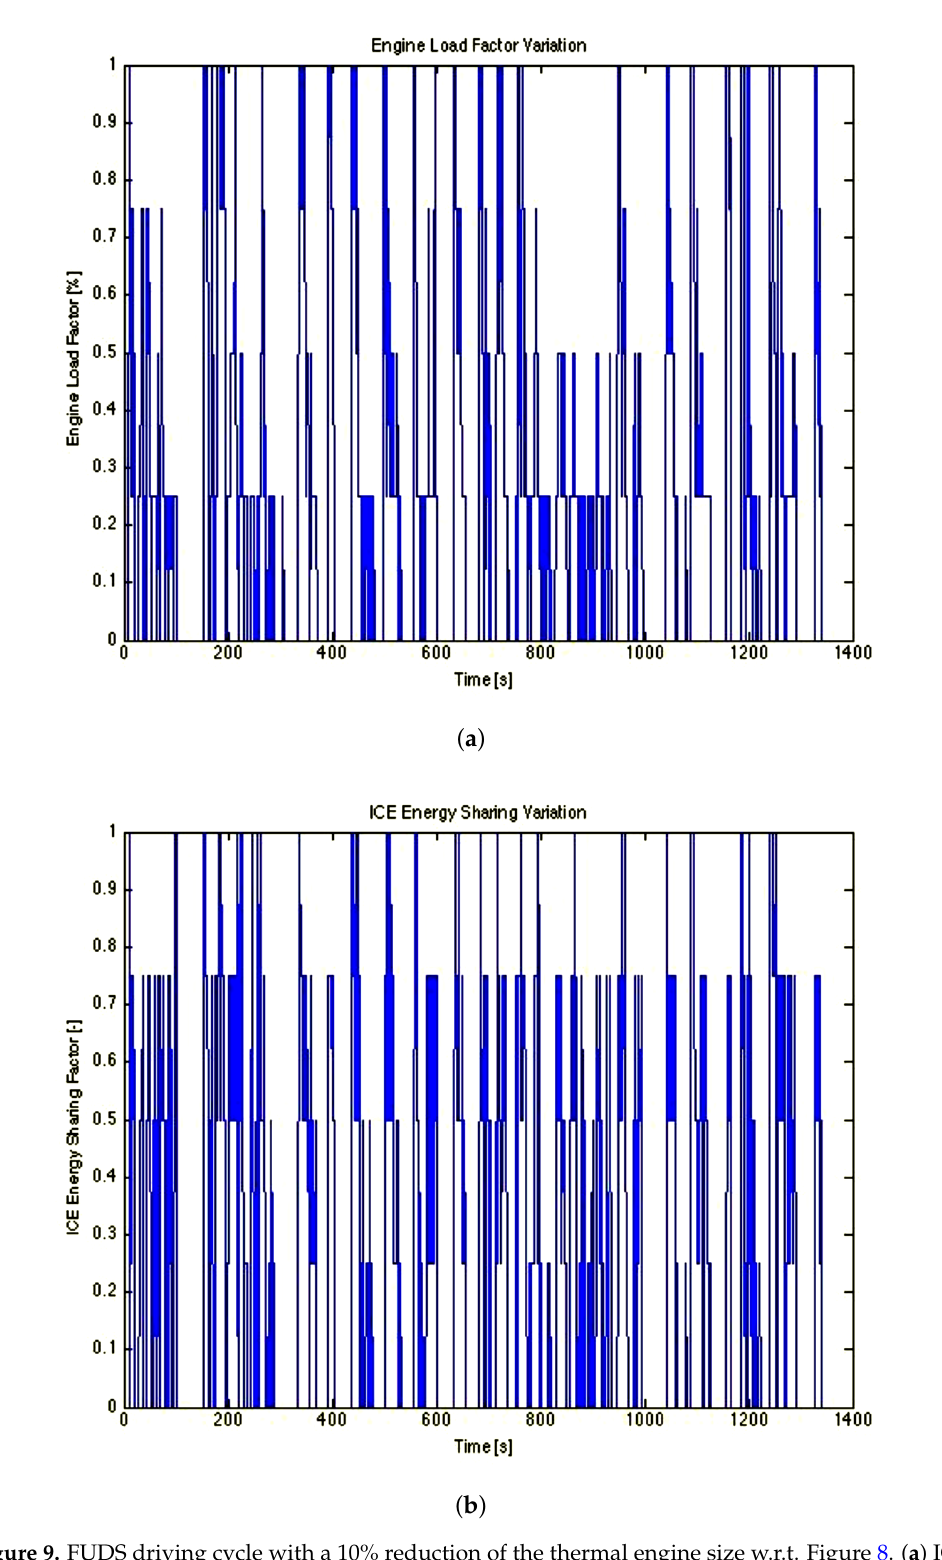
Figure 9. FUDS driving cycle with a 10% reduction of the thermal engine size w.r.t. Figure 8. ( a ) ICE load factor; ( b ) ICE energy sharing